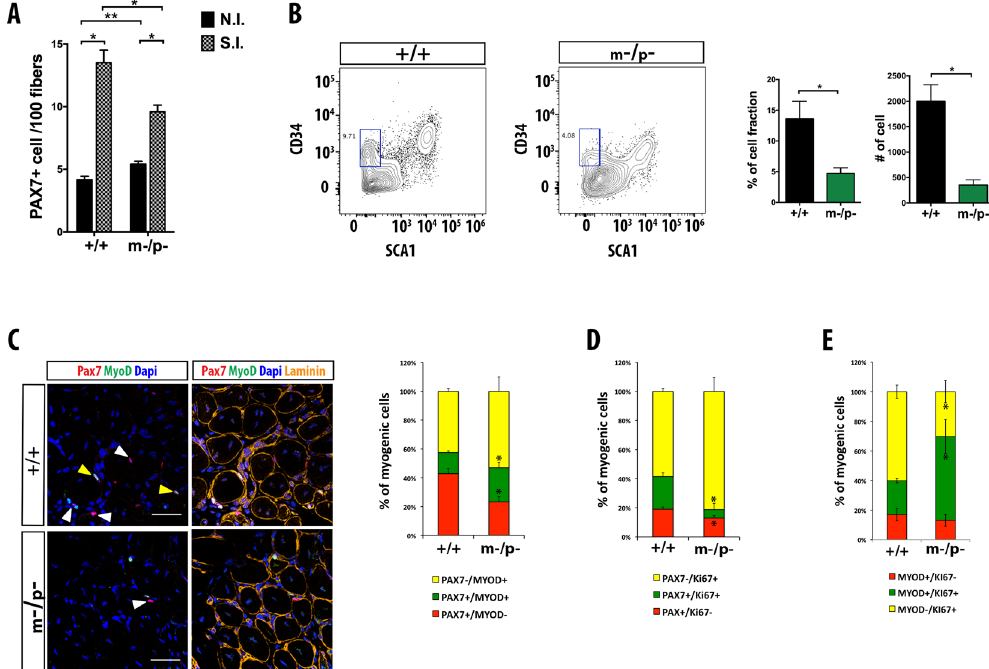
Figure 3. Pw1 null satellite cells display altered self-renewal properties. (A) Quantification of PAX7 positive cells in Pw1 + / + and Pw1 m − /p − 3 month TA muscle before and after two weeks of a single CTX injury (n = 4 for each genotype). NI = non injured; SI = single injured. Values represent the mean number of positive cells ± s.e.m. per 100 fibers. The number of PAX7 positive cells is higher in uninjured Pw1 m − /p − muscle as compared to Pw1 + / + . In contrast, the number of PAX7 positive cells in injured Pw1 m − /p − muscle is significantly lower as compared to Pw1 + / + two weeks after injury. ( B ) Left Panel: Flow cytometric analyses of single cells from Pw1 + / + and Pw1 m − /p − mice TA muscles five days after injury gated for α 7-integrin + /CD34 + /TER119 − / CD45 − /SCA1 − . The gate used to identify CD34 + /SCA − quiescent satellite cells is shown in blue. Right Panel: Histograms showing percentages (left) and absolute cell numbers (right) of quiescent satellite cells CD34 + / SCA − fraction analyzed as shown in (left panel) (n = 3 for each genotype). Quiescent satellite cells CD34 + /SCA − population is reduced in Pw1 m − /p − injured muscle as compared to Pw1 + / + . ( C ) Left Panel: Representative cross- sections of Pw1 + / + and Pw1 m − /p − TA muscles one week after two consecutive CTX injury immunostained for PAX7 (red), MYOD (green), and LAMININ (orange). Nuclei were visualized by DAPI. White and yellow arrows denote PAX7 + /MYOD − (self-renewing) and PAX7 + /MYOD + (proliferating) myogenic cells respectively. Scale bar = 50 μ m. Right Panel: Histograms showing proportions of myogenic cells PAX7 + /MYOD − (red), PAX7 + /MYOD + (green) and PAX7 − /MYOD + (yellow). The proportion of self-renewing cells is decreased in Pw1 m − /p − compared Pw1 + / + , whereas the proliferating and committed myoblasts show a concomitant increase (n = 3 for each genotype). ( D ) Histograms showing proportions of PAX7 + /KI67 − cells (quiescent satellite cells, red), PAX7 + /KI67 + cells (proliferating satellite cells, green) and PAX7 − /KI67 + cells (proliferating myoblast, yellow) from Pw1 + / + and Pw1 m − /p − TA muscles one week after two consecutive CTX injury (n = 3 for each genotype). The proportion of quiescent satellite cells is decreased in Pw1 m − /p − compared Pw1 + / + . ( E ) Histograms showing proportions of myogenic cells MYOD + /KI67 − (committed cells, red), MYOD + /KI67 + (proliferating and committed cells, green) and MYOD − /KI67 + (proliferating cells, yellow) from Pw1 + / + and Pw1 m − /p − TA muscles one week after two consecutive CTX injury (n = 3 for each genotype). The proportion of proliferating and committed cells is increased in Pw1 m − /p − compared Pw1 + / + . Values are expressed as mean ± s.e.m. Statistical analyses were performed using Student’s t-test * P < 0.05, ** P < 0.01 and *** P < 0.001. In all the graphs Pw1 + / + ( + / + ) and Pw1 m − /p − (m − /p −